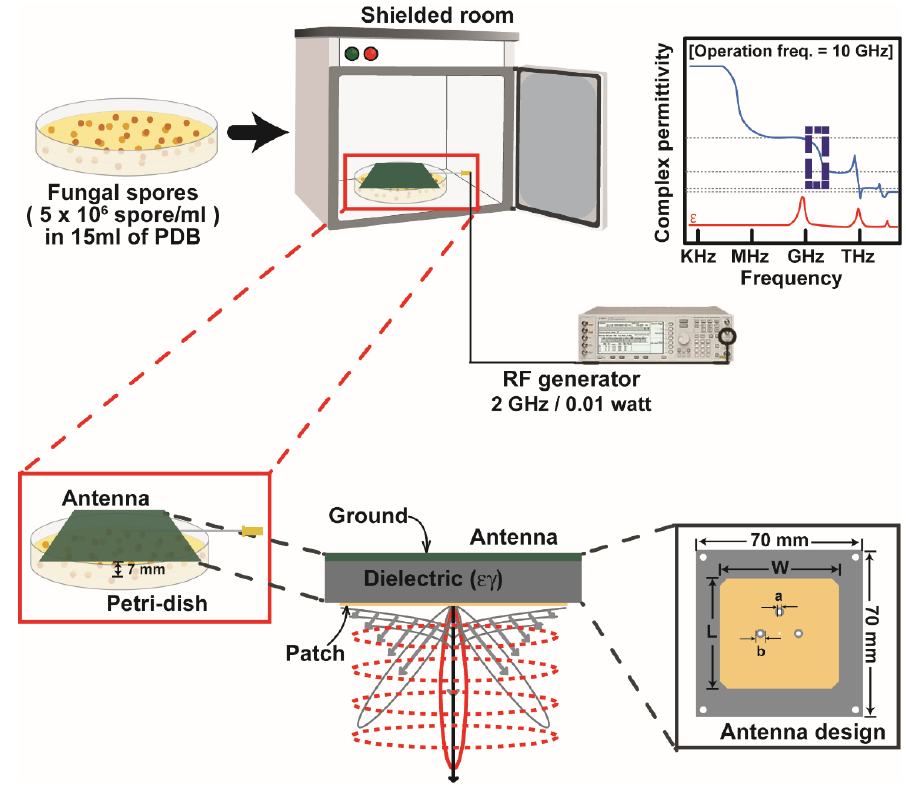
Figure 1. Schematic view of the structure of the antenna and RF (radio-frequency) generator producing RF-EMF (radio-frequency electromagnetic field) and exposure of fungal spores in PDB (potato dextrose broth) medium.